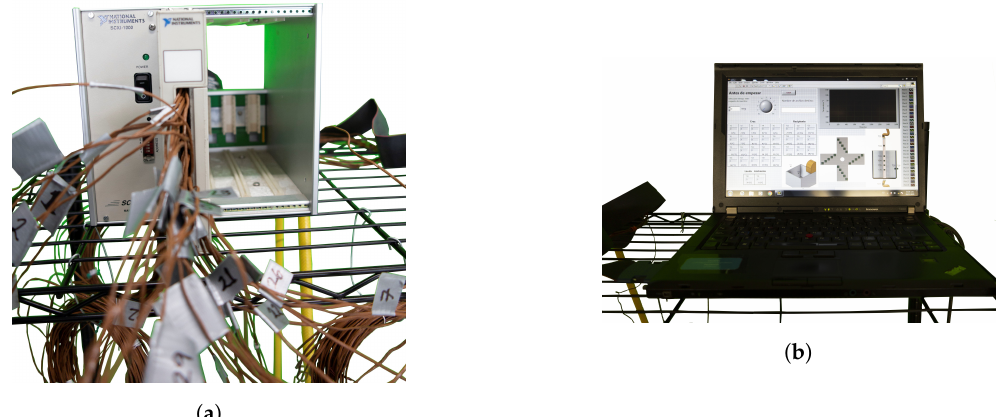
Figure 5. Data acquisition and processing system. ( a ) Data acquisition system. ( b ) Laptop for temperature data